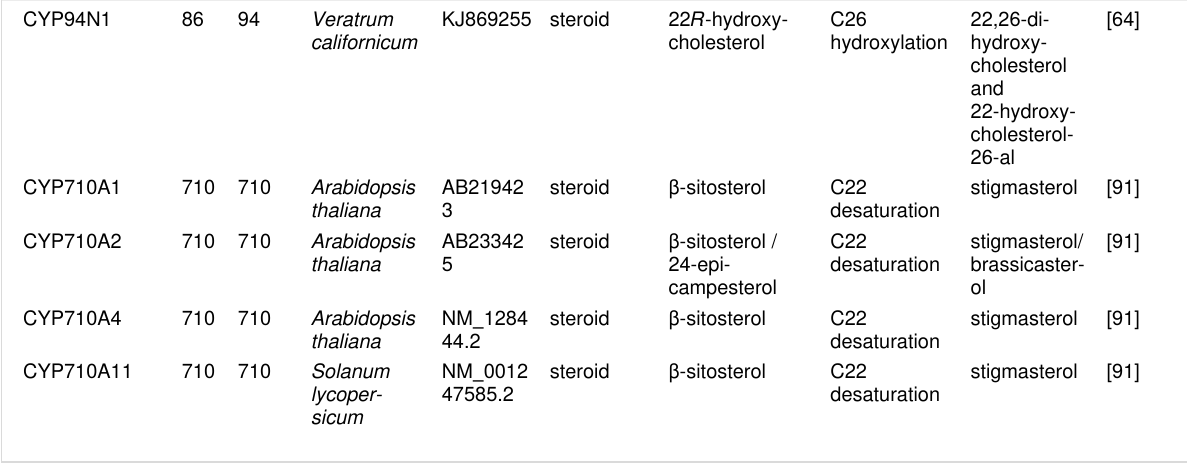
Table 1: List of characterised plant cytochrome P450 monooxygenases (CYPs) modifying triterpenoids or steroids. (continued) CYP94N1 86